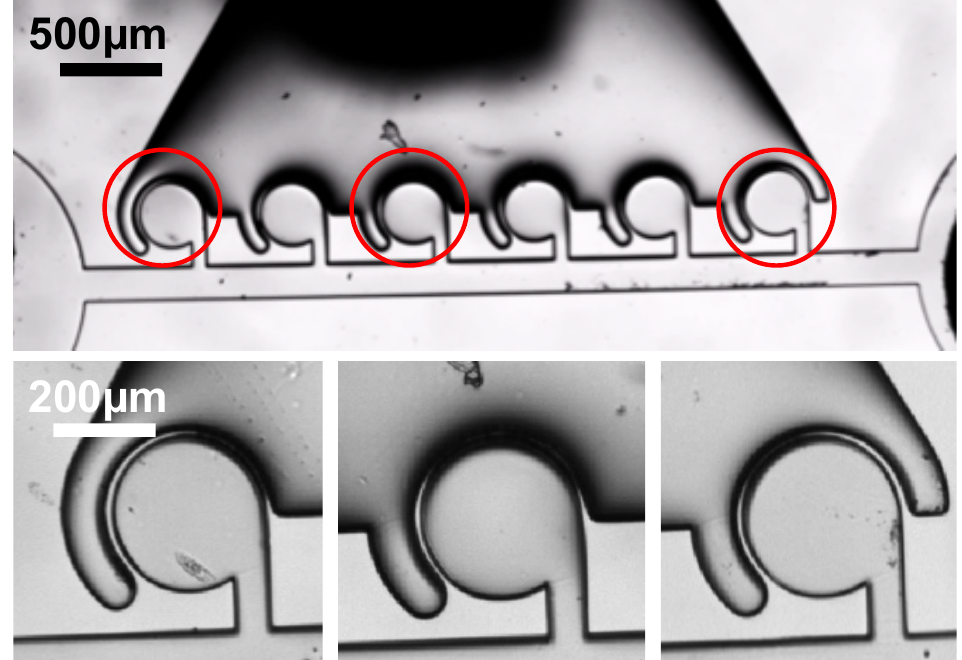
Figure A5. Wall deformation in relation to the position of the pneumatic source. Deformation differeed depending on the position of the chamber.